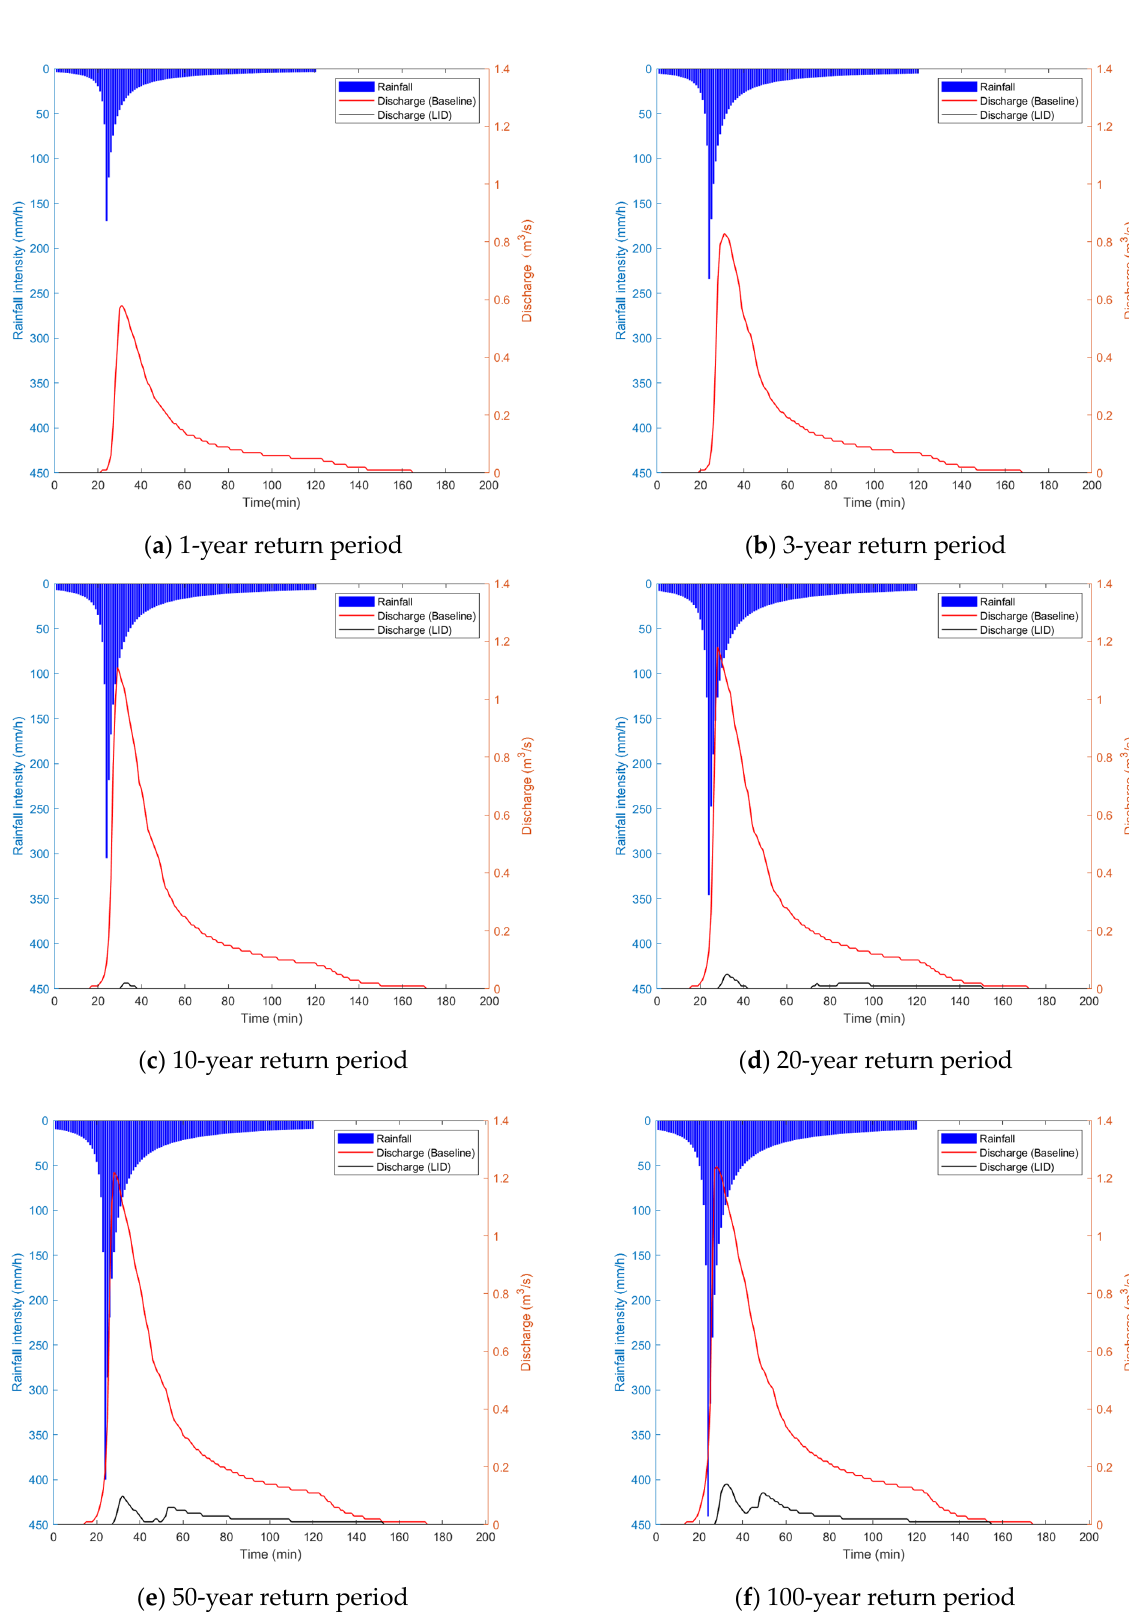
Figure 6. Hydrographs of the conduit at the outlet in the 1-yr ( a ), 3-yr ( b ), 10-yr ( c ), 20-yr ( d ), 50-yr ( e ), and 100-yr ( f ) design storms. Table 7. Peak flows of the pipe at the outlet.